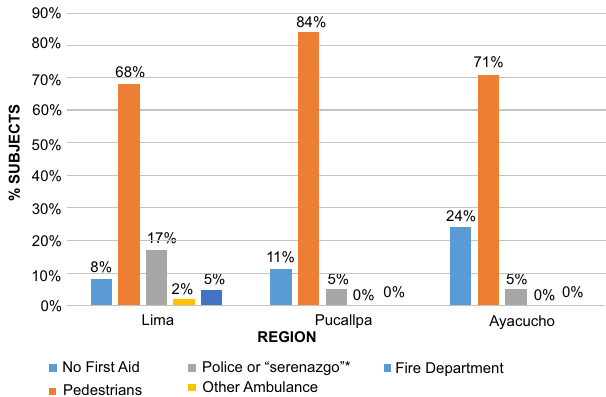
Figure 3. Caregiver that provided initial care during the intra-hospital period after the incident. There were a total of 644